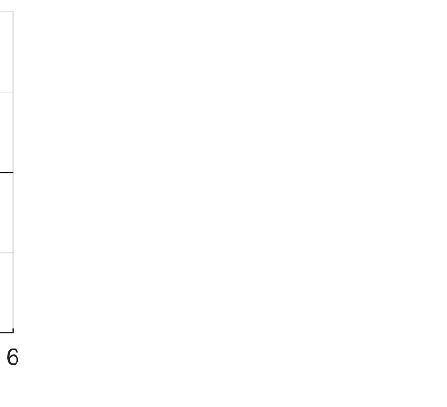
Figure 6. Transients of difference between motor and load speed for analyzed controller cases.